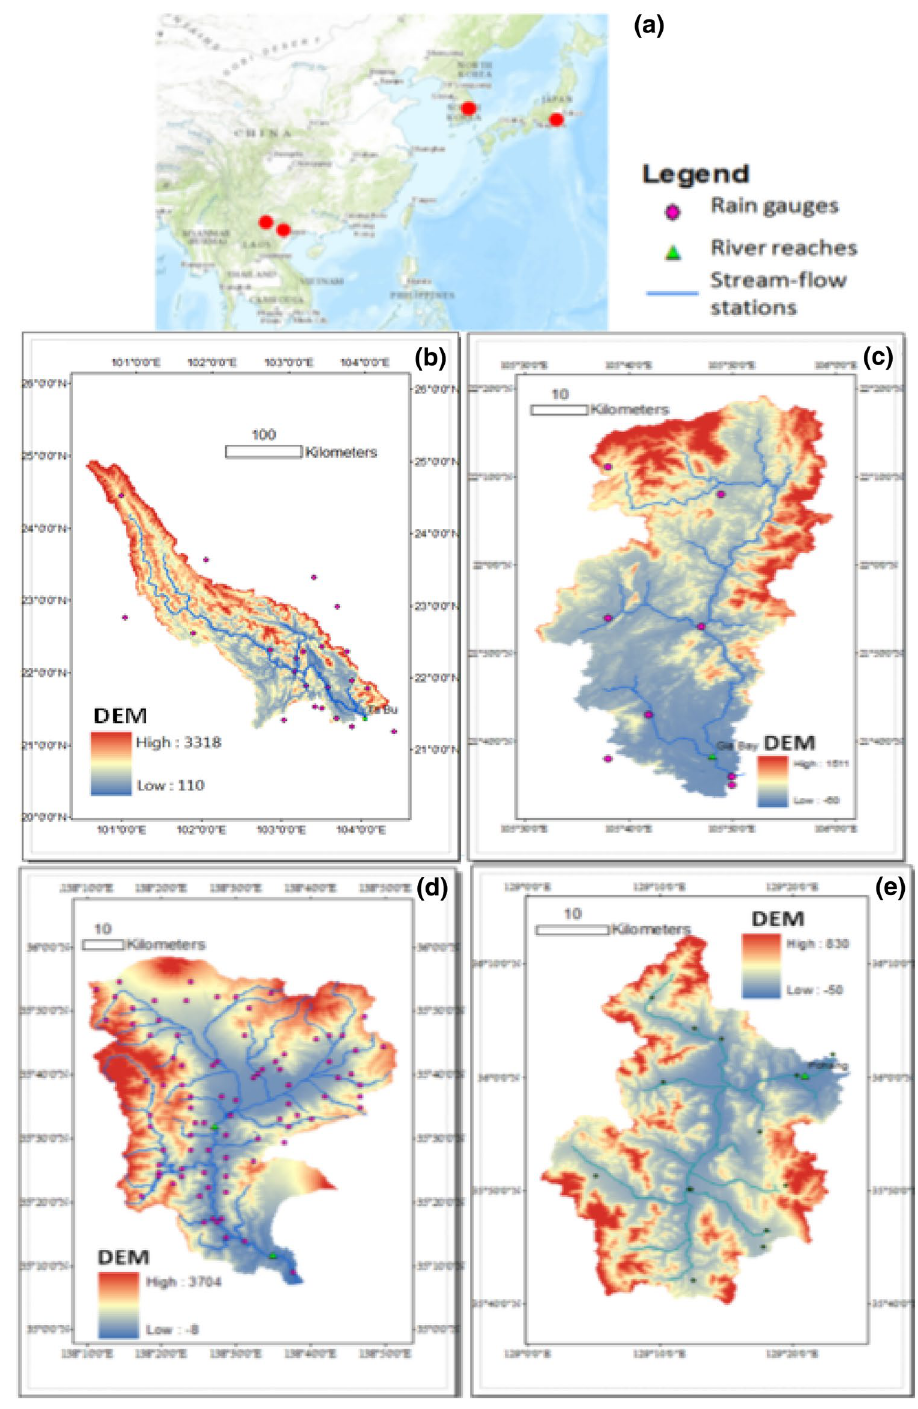
Fig. 1 a Locations of targeted river basins (red points) and rain gauges, stream-flow gauges